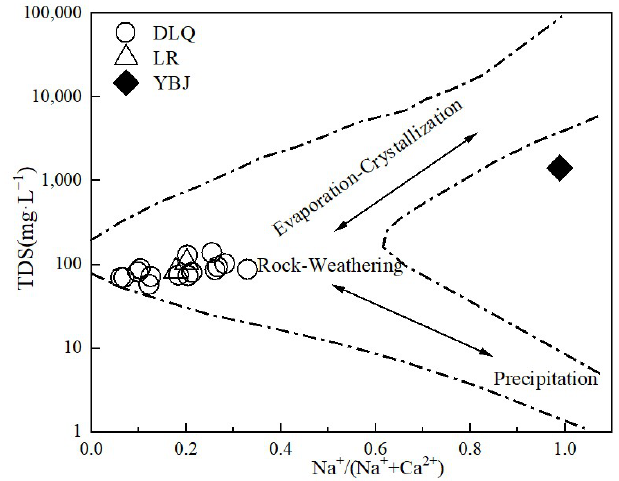
Figure 3. The Gibbs graph of major ion compositions in DLQ, LR, and YBJ geothermal water.